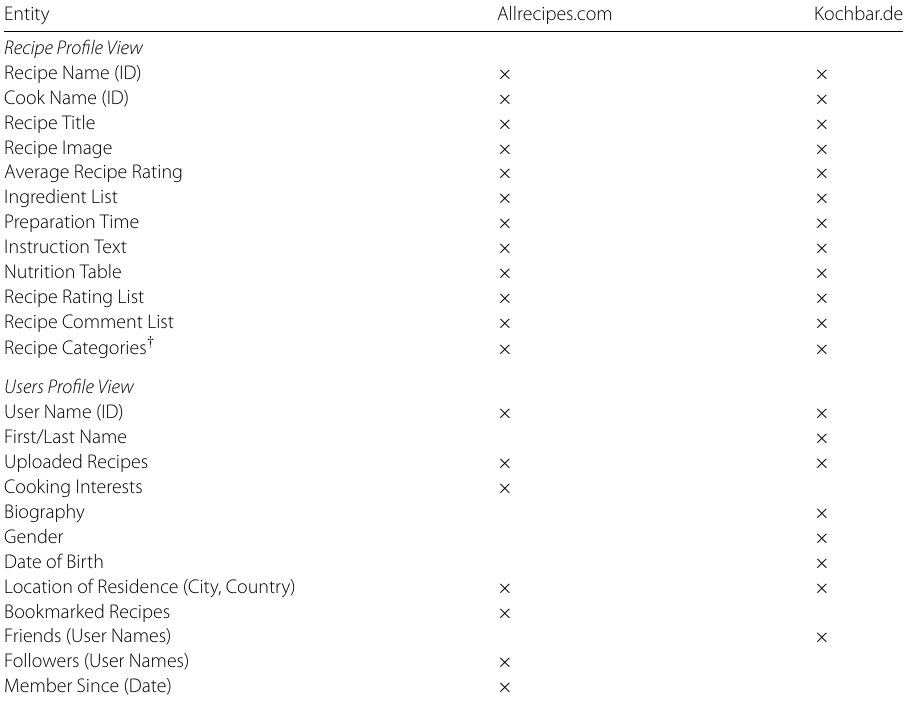
Table 1 Entities (meta-data) available in Allrecipes.com and Kochbar.de recipe and user profile views as employed for the study. As shown not all types of entities are available for both sites as indicated with a × symbol